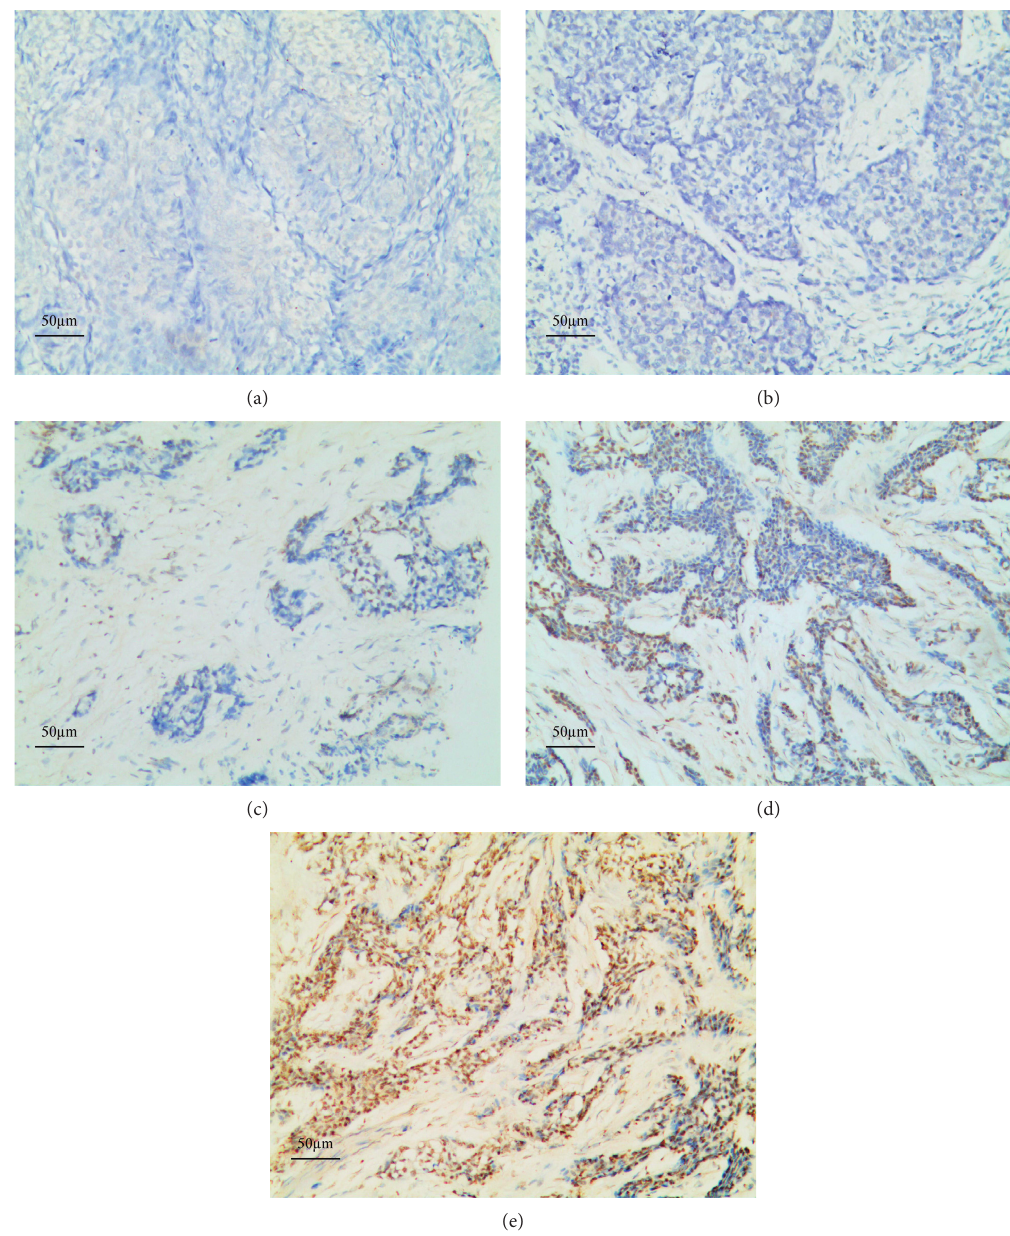
Figure 1: Grading of the EBER reaction (ISH) in sebaceous carcinoma of the eyelid. Sebaceous carcinoma of the eyelid, magnification 100x. Negative control (a), Grade 1+ (b), Grade 2+ (c), Grade 3+ (d), and Grade 4+